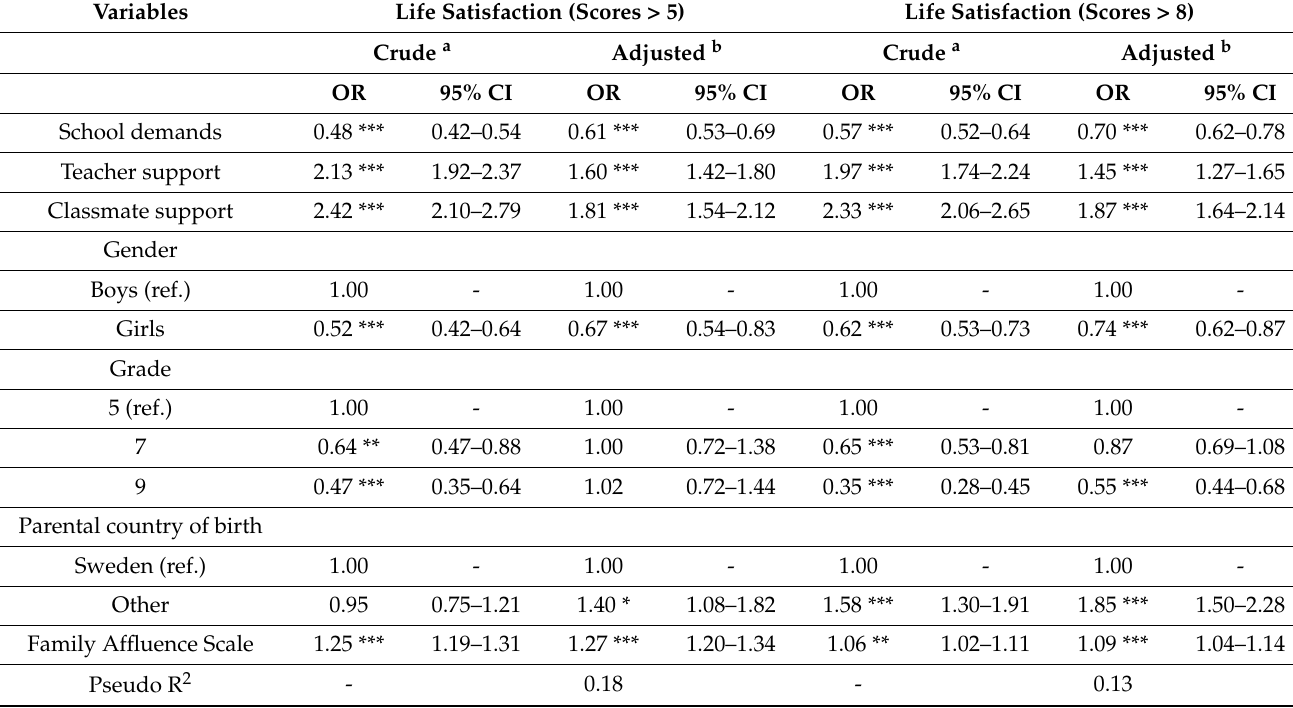
Table 3. Odds ratios and 95% confidence intervals from binary logistic regressions of life satisfaction ( n = 3614).